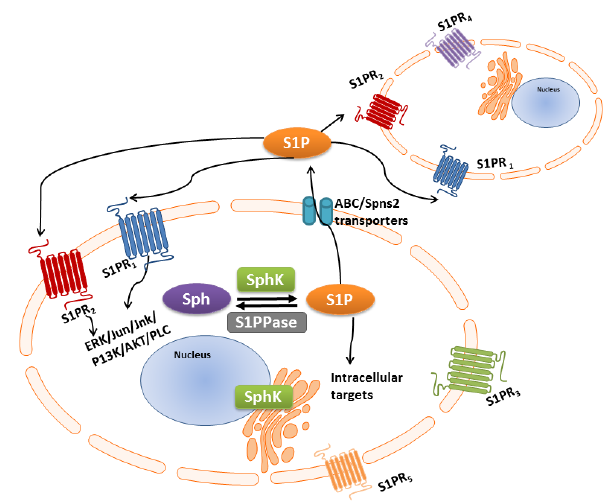
Figure 2. Complexity of SphK-S1P “inside-outside” signaling. SphK is a lipid enzyme catalyzing the phosphorylation sphingosine to its active form S1P. S1P can act in an autocrine or paracrine manner. S1P is exported extracellularly through the ABC [106] and Spns2 (Sphingolipid Transporter 2) transporter [107,108] transmembrane proteins or can act intracellularly on yet unknown targets.